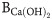
SEM and FESEM for (a) RH, and (b) BCa(OH)2, magnified 1000 times.